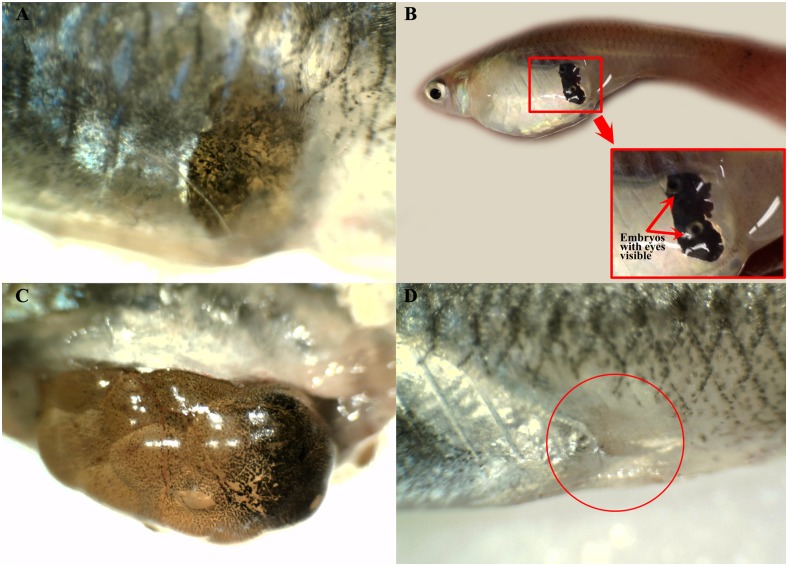
Gravid spot of G. holbrooki.(a) Gravid spot of a female G. holbrooki with high intensity value (less dark). The yellowish colour of the yolk/eggs can be seen when observed under dissecting microscope. (B) Embryo’s eyes at final developmental stage are visible through the gravid spot (red arrows). (C) Black pigment is scattered over the sac but is concentrated on the posterior margin of the ovarian sac. (D) Area of the skin corresponding to the gravid spot (circled red) appears as a translucent window after the ovarian sac was removed from the body cavity. Dorsal to the top and anterior to the left.